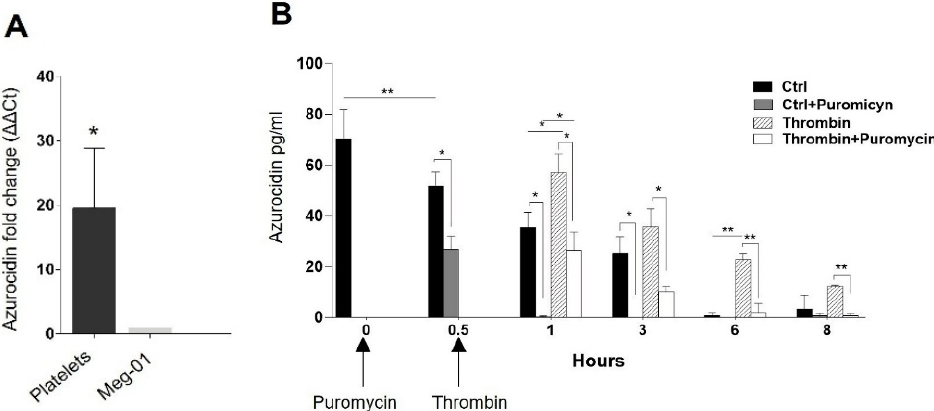
Figure 4. Platelets translate azurocidin. ( A ) Total RNA from Meg-01 cell line and peripheral blood platelets was extracted to quantify azurocidin expression by qRT-PCR. Graphs show the average expression values, calculated using the 2 −ΔΔ Ct method and normalized for β -actin expression. Data are representative of three independent experiments. ( B ) 50 × 10 6 washed platelets from peripheral blood were treated with puromycin, and 0.5 h later received thrombin stimulation (the arrow indicates the time at which the treatments were added). Platelets were not stimulated with thrombin in the control condition, as indicated in the figure. Subsequently, we obtained total protein (cell and supernatant) at different times and quantified the amount of azurocidin by ELISA. In the figure, the graphs represent the mean ± standard deviation of 3 ( A ) or 4 ( B ) independent experiments. Statistical significance was determined by Dunn Sidak multiple comparison test ( A ) and 2-way ANOVA with repeated measures ( B ) and is represented as * p < 0.05, ** p < 0.01.